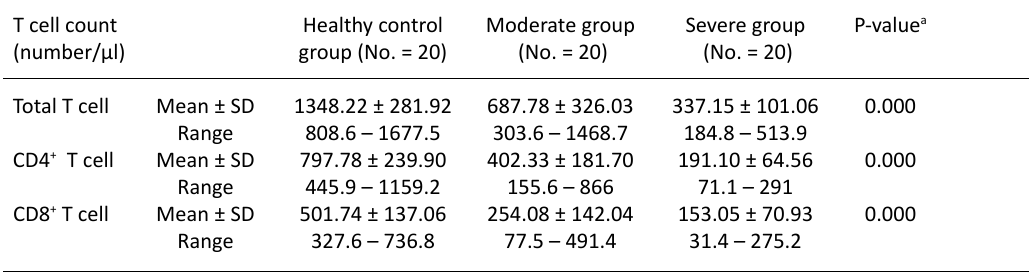
table 1. Comparison between the healthy control, moderate, and severe groups regarding Total T cell count, CD4 + T cell count, and CD8 + T cell count